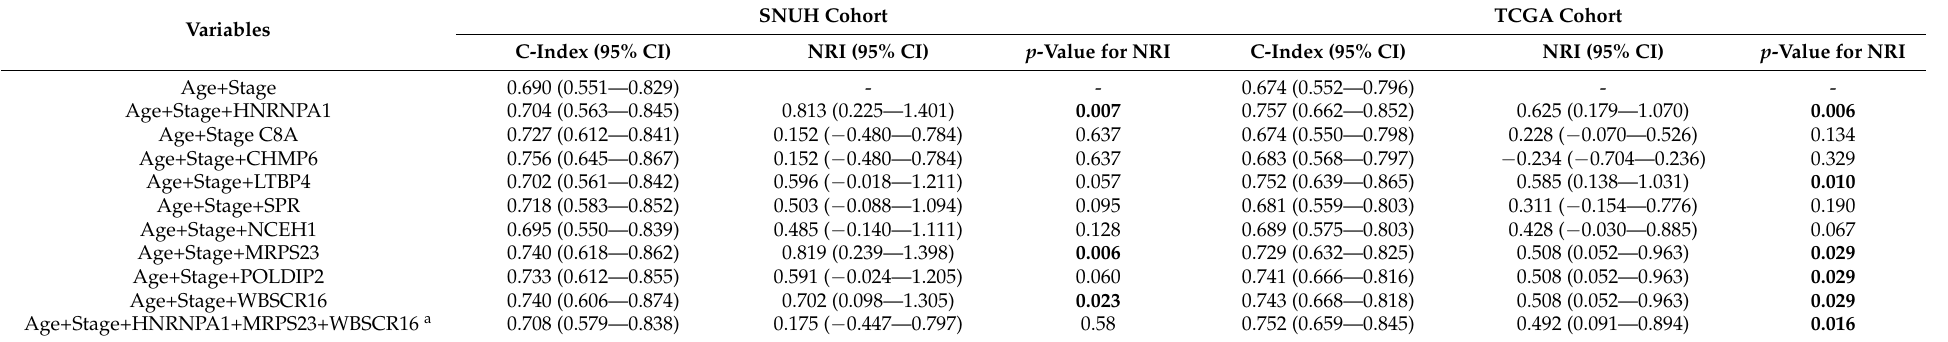
Table 3. C-index and net reclassification